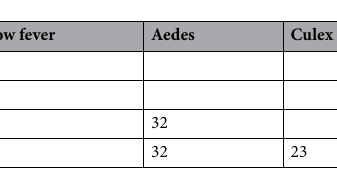
Table 3. Comparison of flavivirus heatmaps. The number of differences in third nucleotide bias (color, not magnitude) between heatmaps for specific flavivirus genomes is shown. The two insect specific viruses (Aedes and Culex) and two viruses that cause disease in humans (Dengue and Yellow fever) are also compared to the Flaviviridae